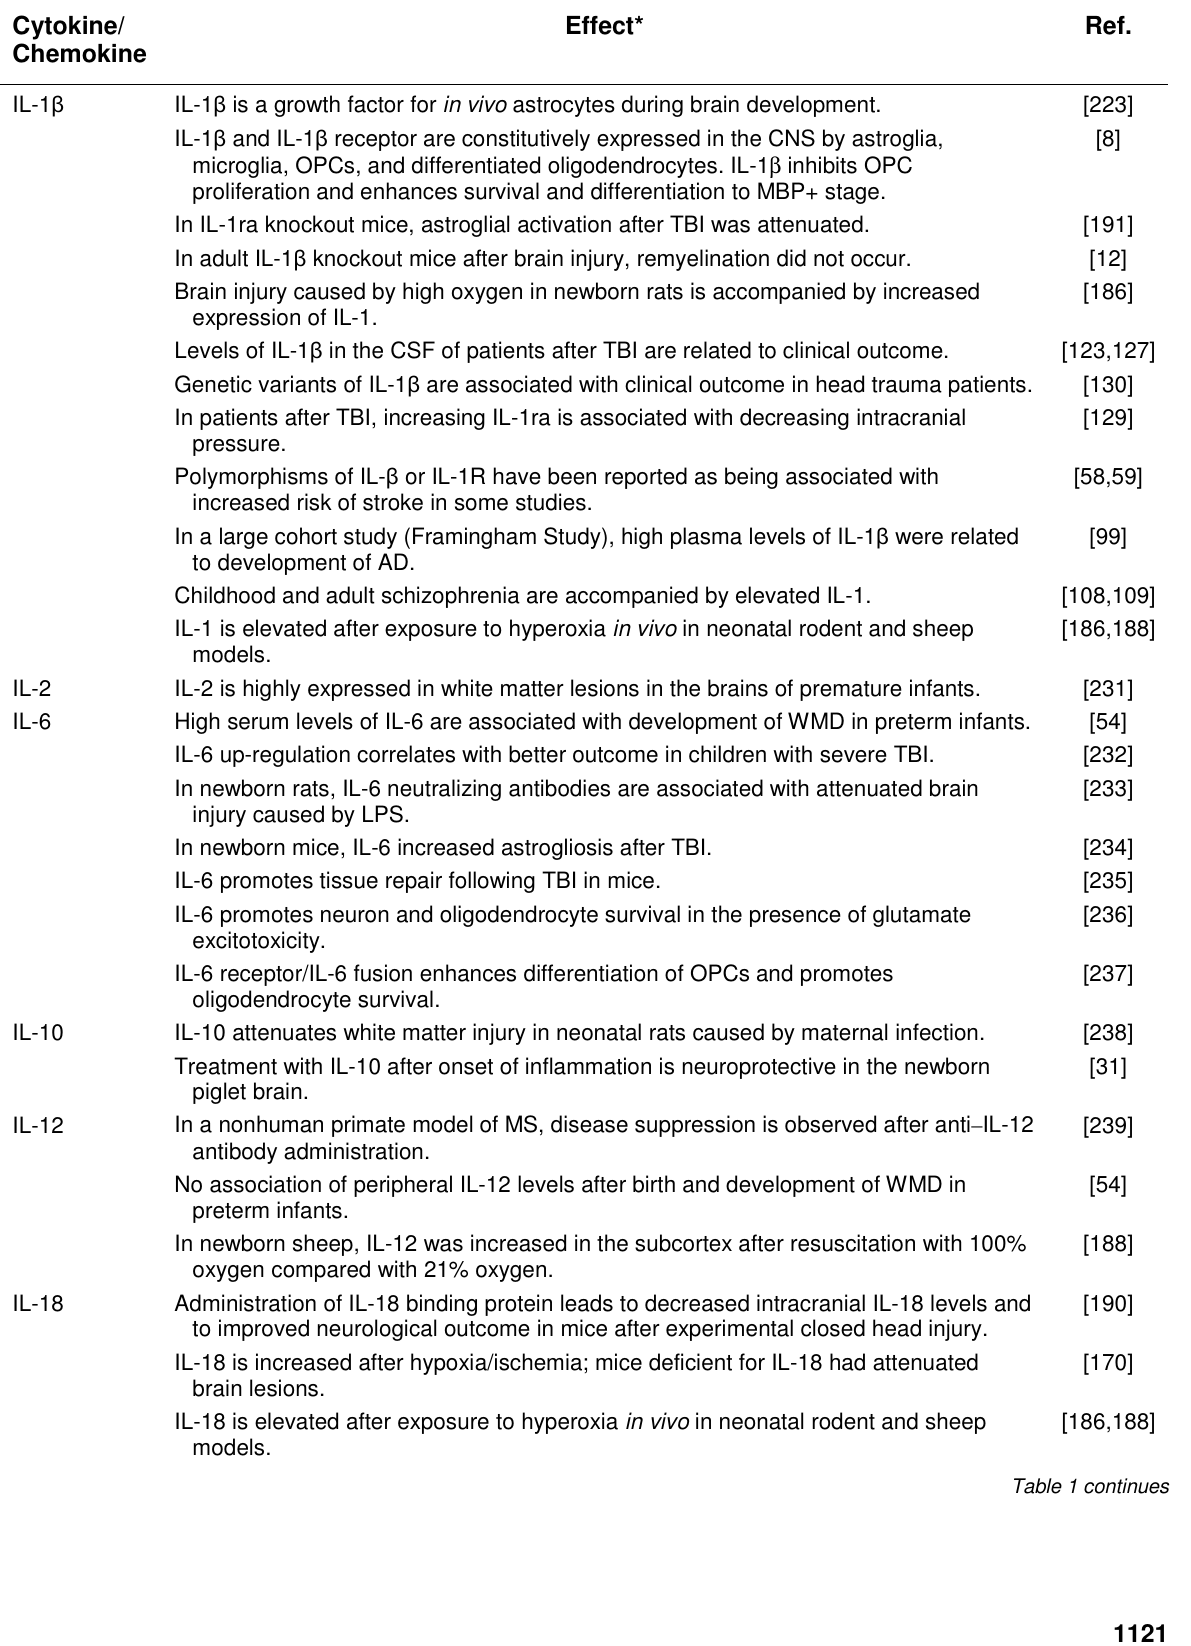
Cytokines and Chemokines Associated with White Matter